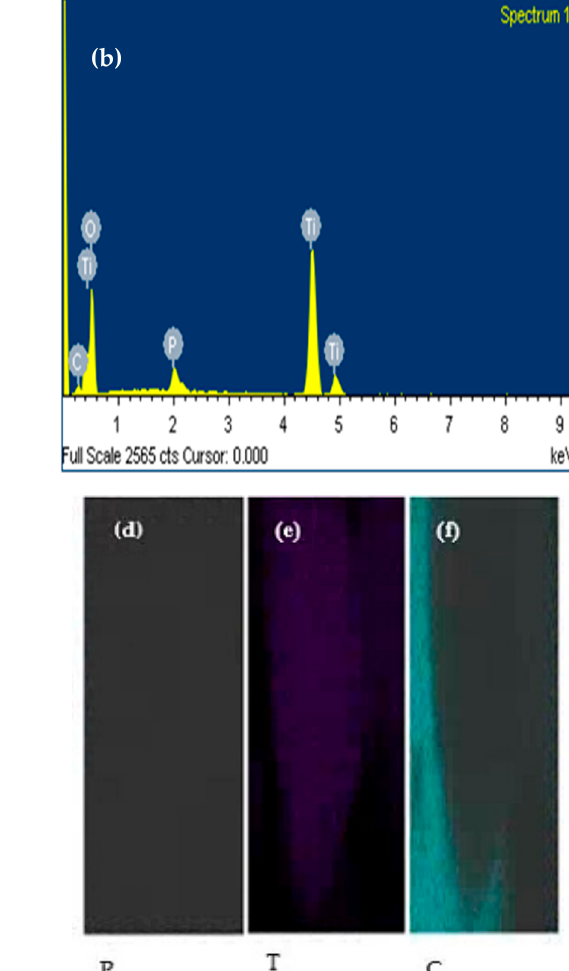
Figure 5. UV–vis absorption spectra of PN-TiO 2 with various PN content levels.